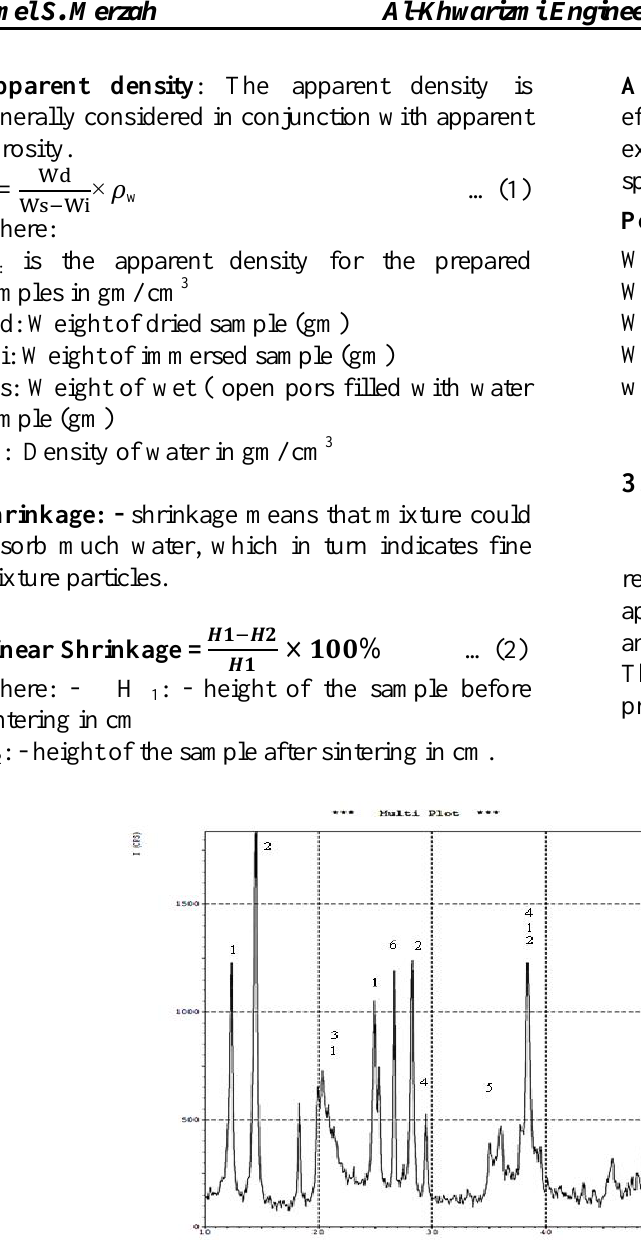
Fig .4. X-ray diffraction pattern for Iraqi Bauxite as reserved from the Geologized surveying